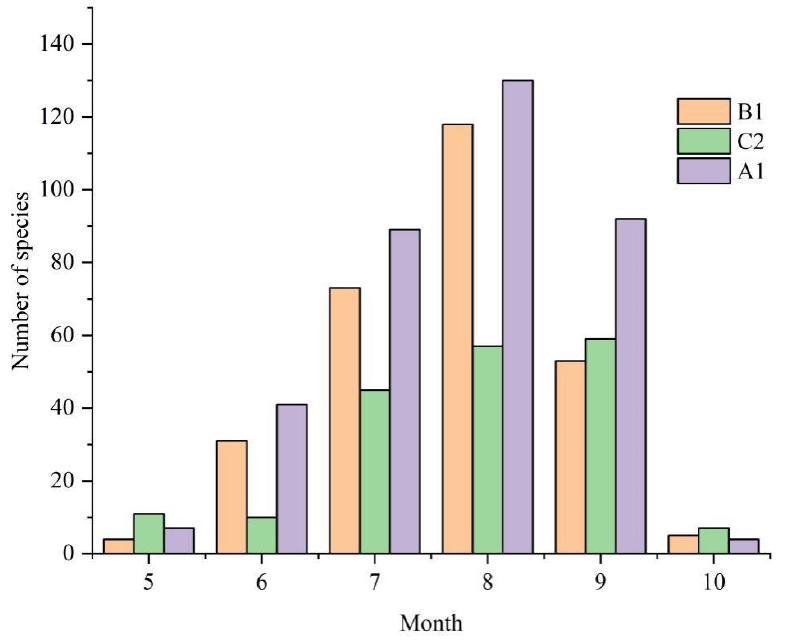
Figure 9. Relationship between macrofungi occurrence and month in three different investigation sites from Jilin Province. The results showed that they mostly arose from July to September. A1: